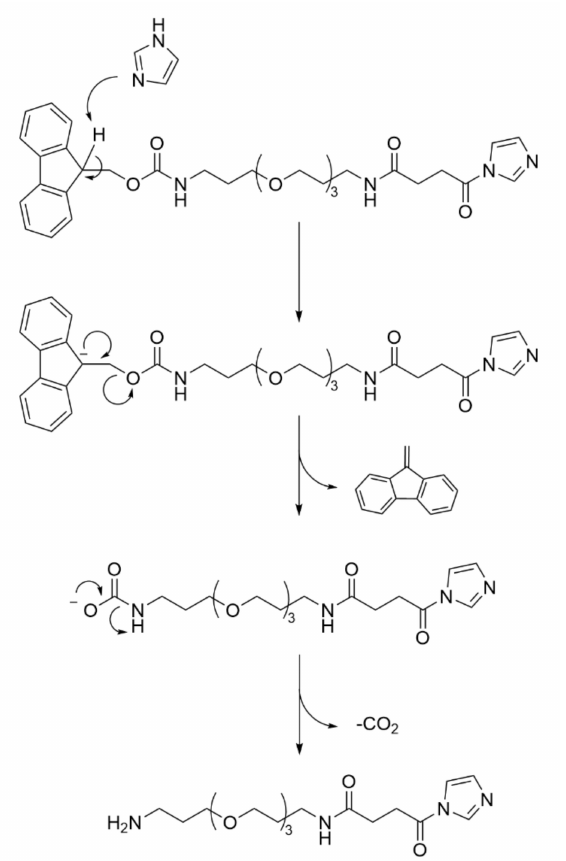
Figure 7. Elimination of the fluorenylmethoxycarbonyl (Fmoc) group from CDI-activated compound 2 mediated by